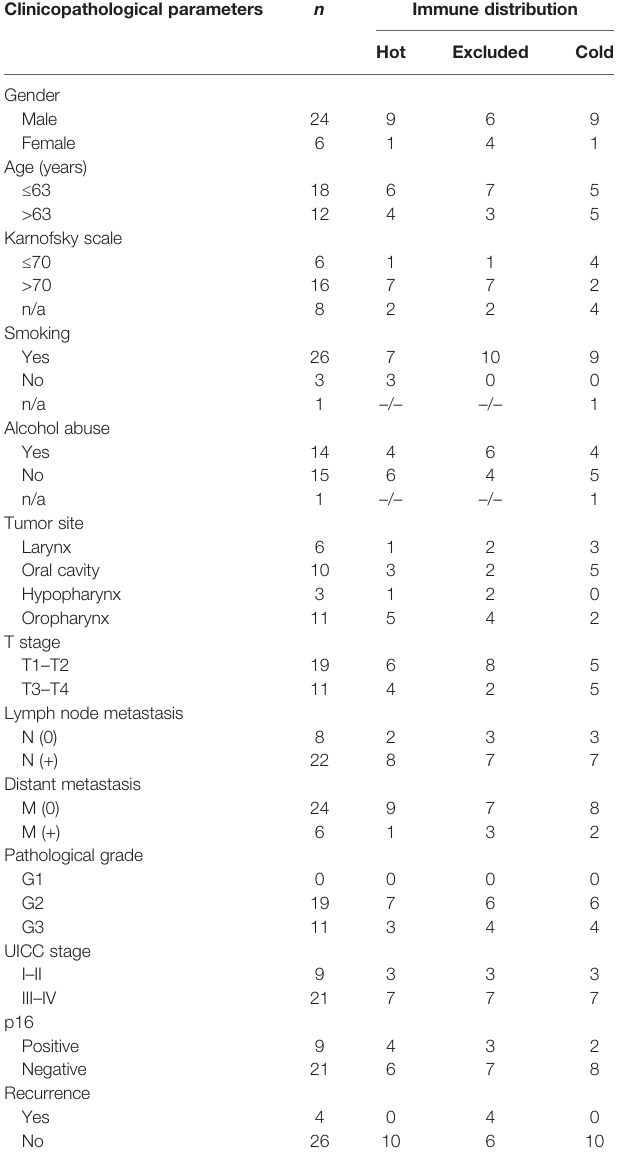
TABLE 1 | Clinicopathological data of patients. Clinicopathological